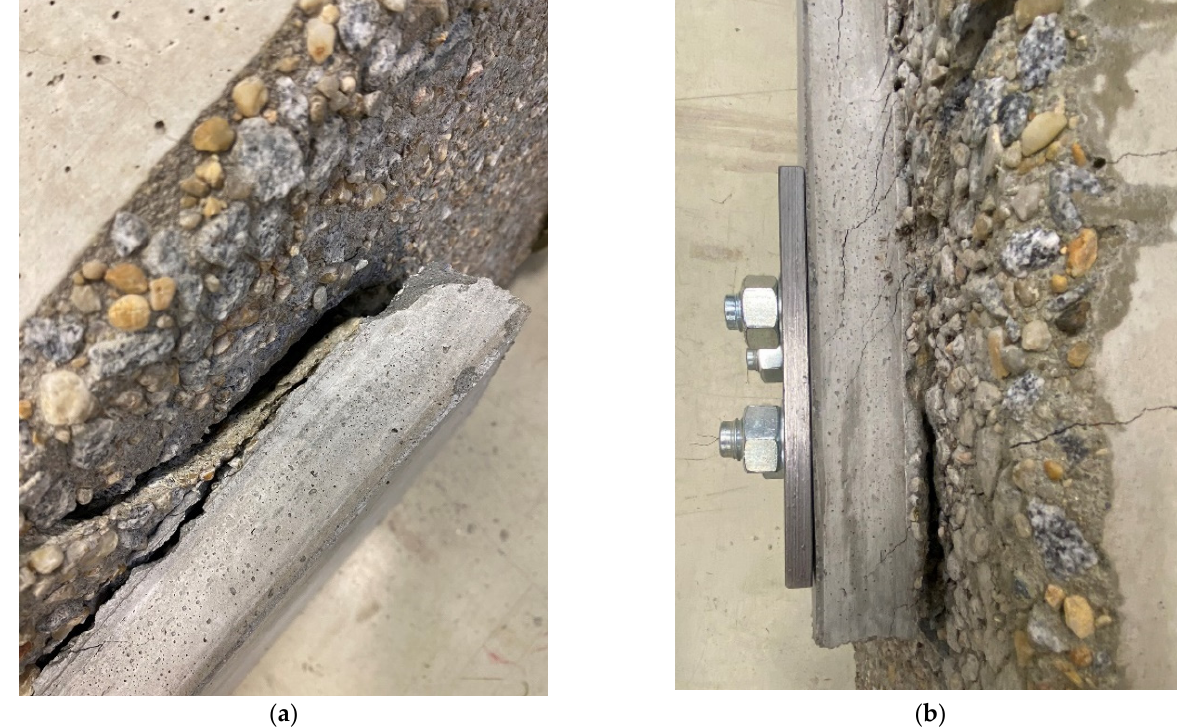
Figure 21. Concrete cover separation: ( a ) specimen 1; ( b ) specimen 2. (Photo: CARBOCON GMBH).